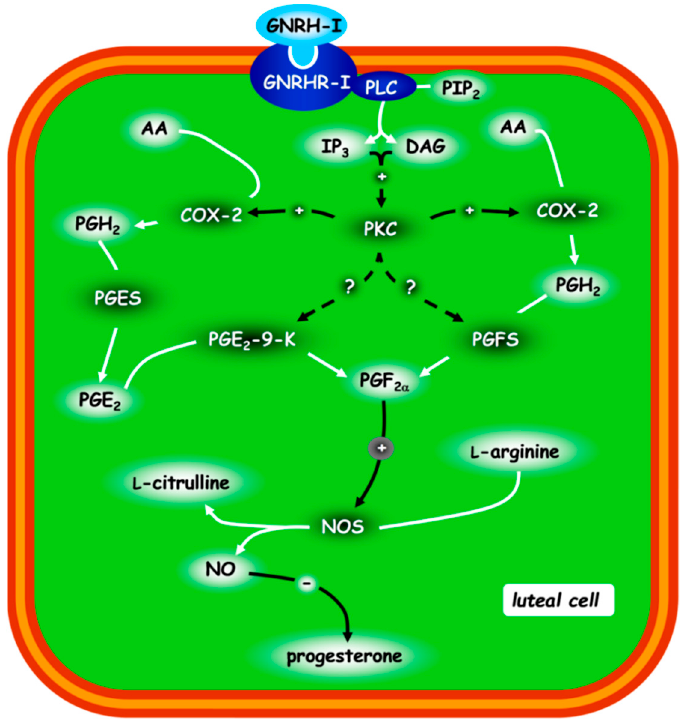
Figure 3. Schematic representation of the post-receptorial mechanism of GnRH-I regulating the progesterone release in rabbit CL. The other possible protein kinase C (PKC) targets are represented by hatched lines. Figure from the study by Zerani et al. 2010 [85]. For acronyms, see the list of abbreviations in the text.